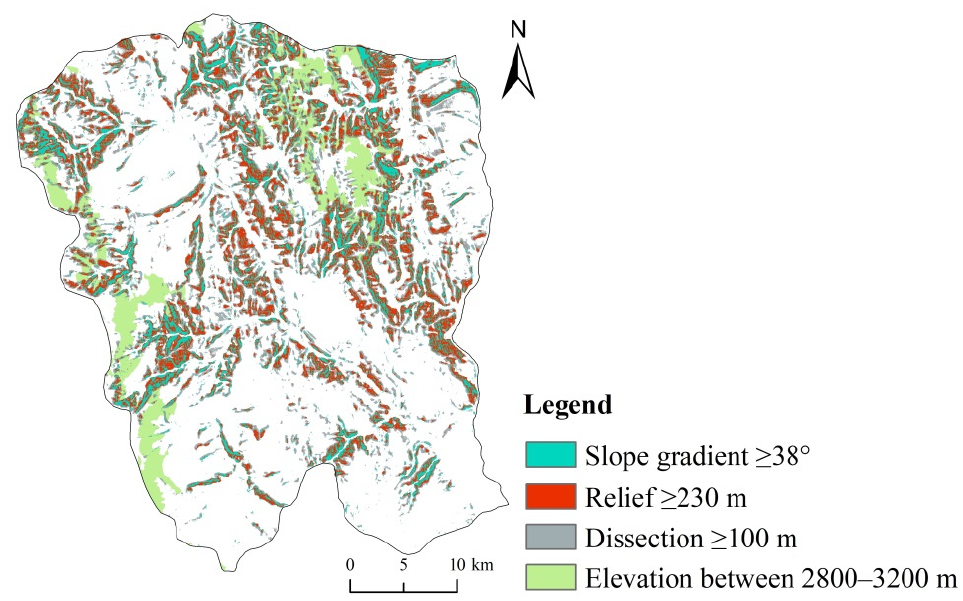
Figure 9. Area with intense gully erosion under various topographic factors. Most of the areas covered by the four indicators overlapped, indicating that the development of the gully was related to the topography.